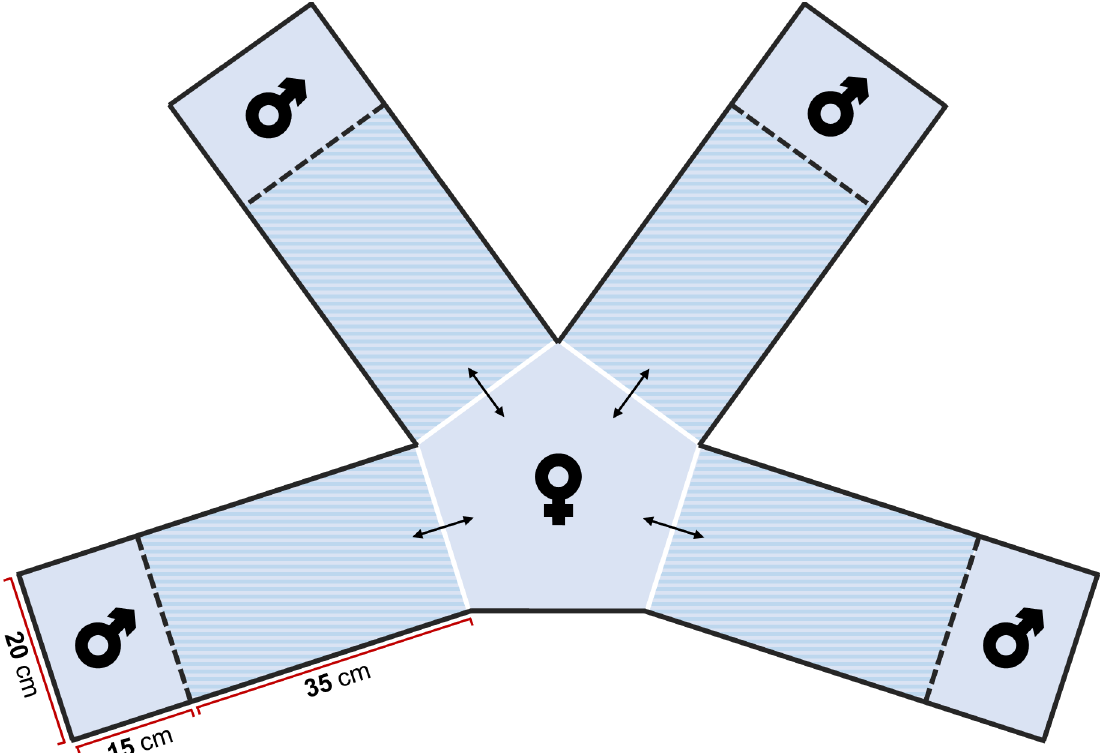
Fig 3. Experimental tank specially designed for the study of S . alburnoides mate choice. The choice areas for each male genomotype are dashed. The proportion of time spent by females in each of these areas was used as a measure of preference, being the central area considered neutral. Male compartments were delimited by transparent perforated acrylic plates, allowing the passage of all types of stimuli between male and